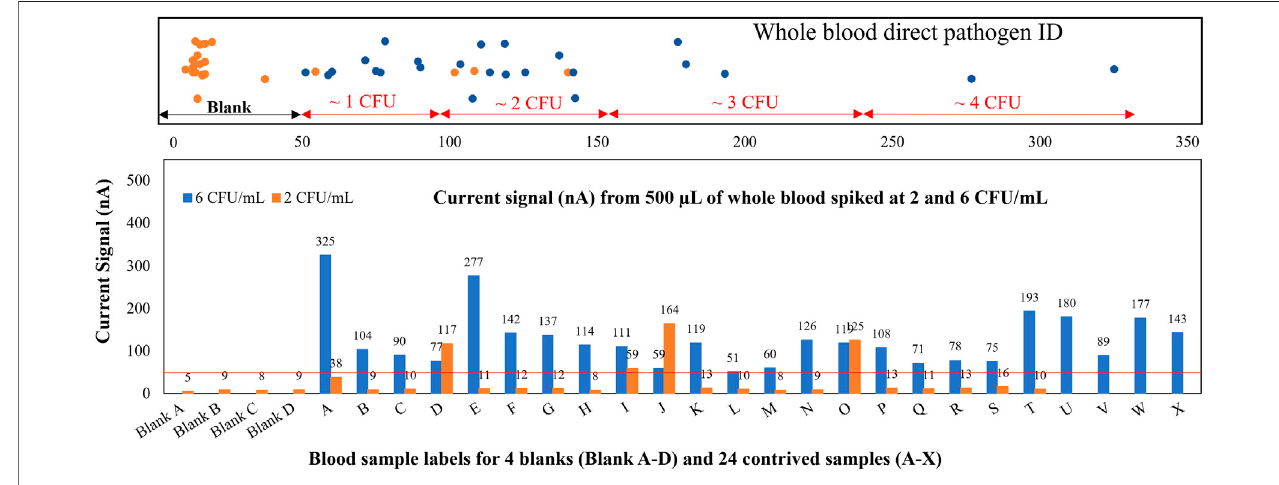
FIGURE 5 | Whole blood direct pathogen ID. Gram-negative samples spiked at 2 and 6 CFU/ml, assay results re fl ect the probability inherent in spiking a 0.5-ml whole blood sample at approximately 2